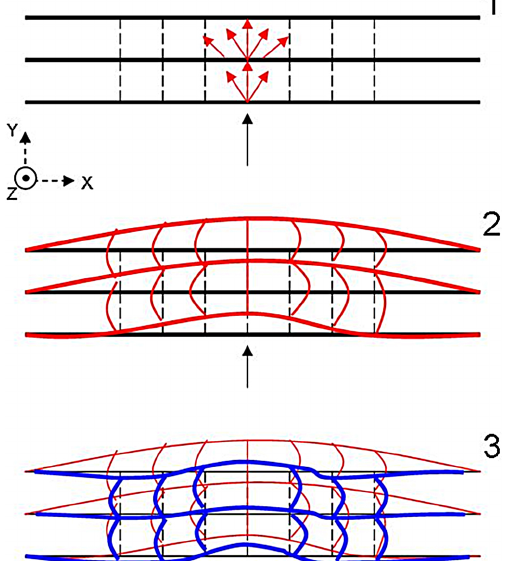
Figure 13. Schematic representation of the deformation of the sand- wich wall at the impact height (2m above the ground): (1) beginning of impact, (2) maximum deformation stage, (3) residual deforma-